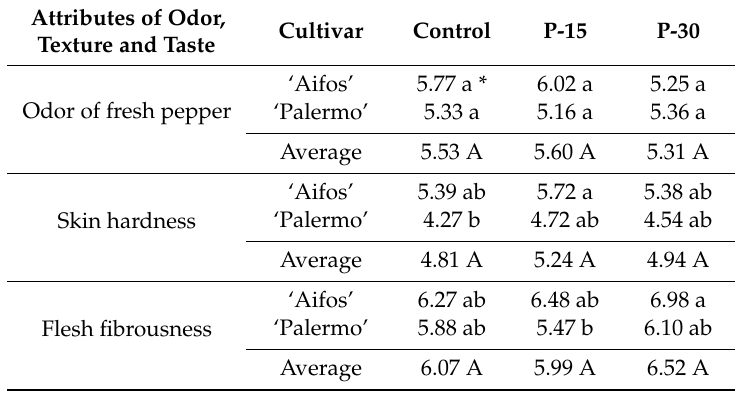
Table 4. The results of sensory analysis concerning odor, texture and taste for pepper fruits as a ff ected by cultivar and PP treatment, scale 0–10 (average of two